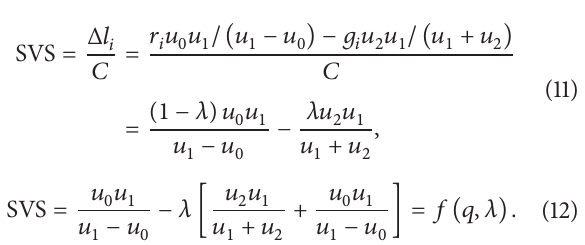
that is, the propagation of congestion. During a cycle, queue back propagates Δ𝑙 𝑖 , and the average speed is